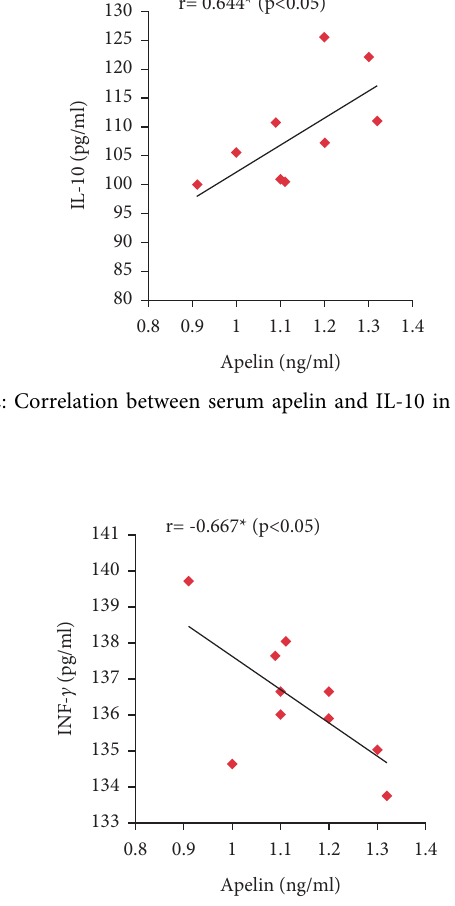
Figure 13: Correlation between serum apelin and IFN- c in the PE group.